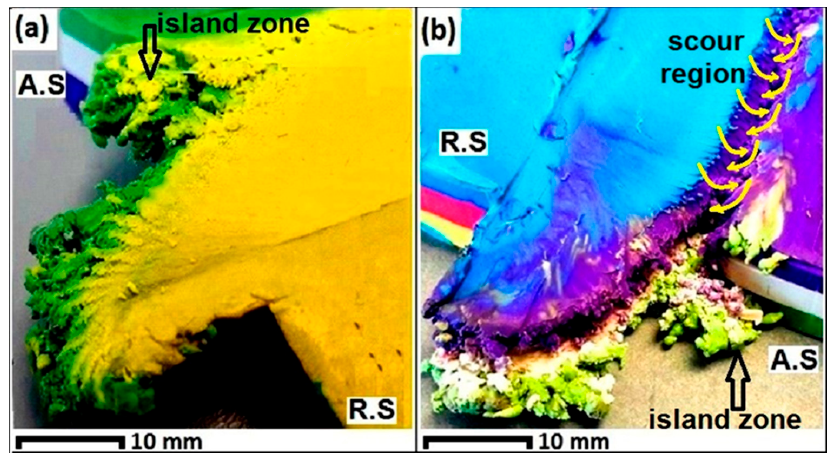
Figure 6. The stage of the entry zone, ( a ) top view, and ( b ) bottom view.